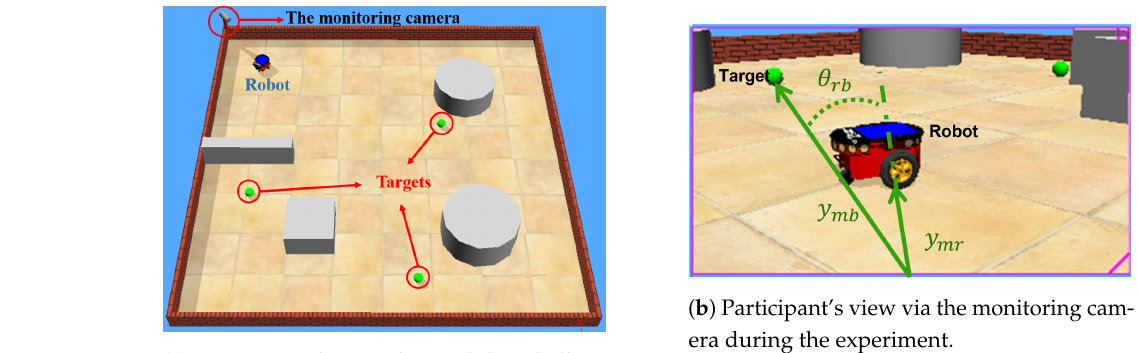
Figure 4. Scenario for training data collection